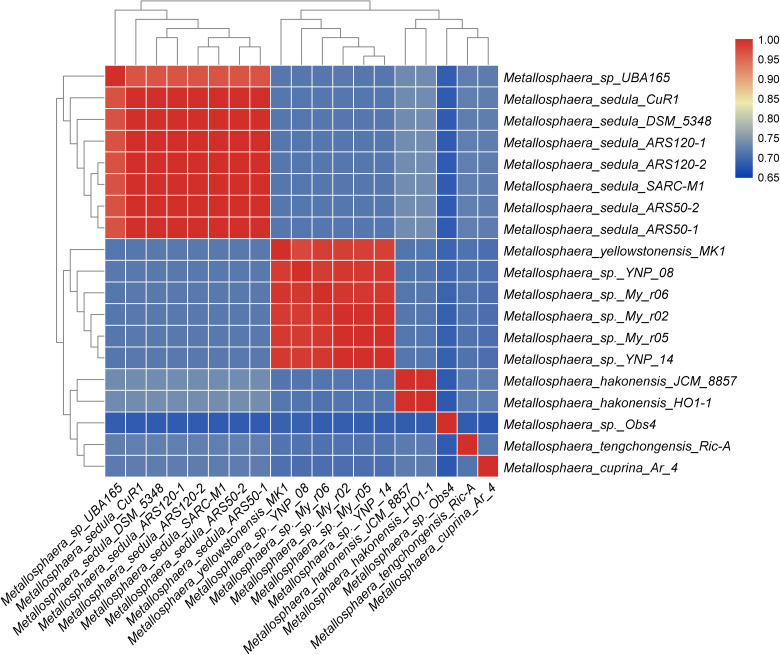
Heat map showing species boundary of genus Metallosphaera based on ANI value (cutoff value = 96%), which is a universally accepted genomic measure for prokaryotic species delineation (Richter and Rossello-Mora, 2009).